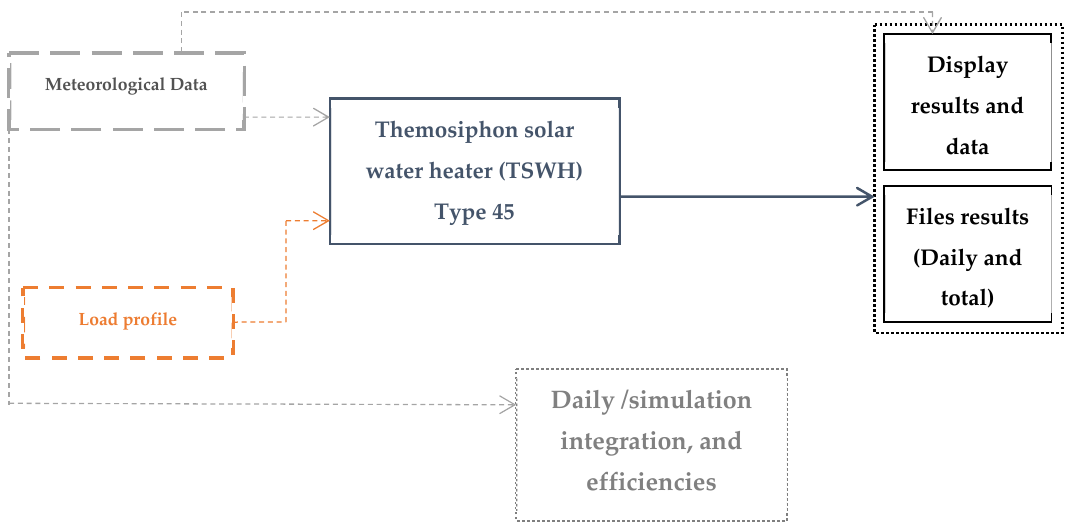
Figure 11. Thermosyphon diagram executed under the TRNSYS program.